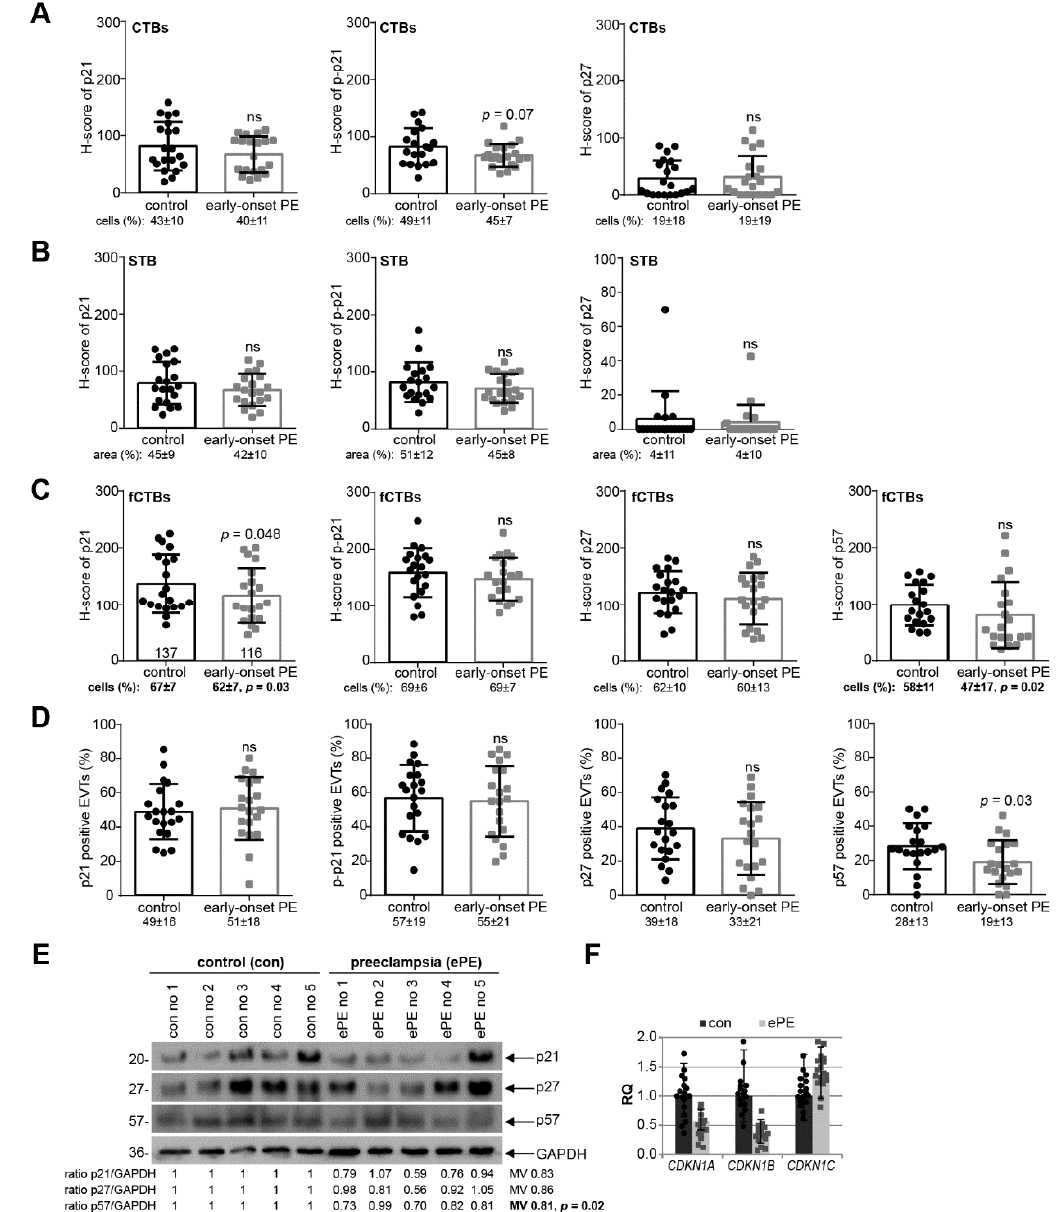
Figure 3. p21 expression is reduced in fCTBs of early-onset PE samples. ( A – C ) Quantification of cell cycle regulators in placental sections of control donors (control, n = 20) and patients with early-onset PE (ePE, n = 20) using the H-score method. The results are presented as bar and scatter plots showing the mean value with SD. The percentage of positive stained cells/area is shown under each graph. ( A ) H-score of p21 (left panel), p–p21 (middle panel), and p27 (right panel) for CTBs. ( B ) H-score of p21 (left panel), p–p21 (middle panel), and p27 (right panel) for the STB area. ( C ) H-score of p21 (left panel), p–p21 (second panel), p27 (third panel), and p57 (right panel) for fCTBs. ( D ) Quantification of p21 positive (left panel), p–p21 positive (second panel), p27 positive (third panel), and p57 positive EVTs (right panel) in %. ( E ) Western blot analysis with extracts from placental tissues is shown. Glyceraldehyde-3-phosphate dehydrogenase (GAPDH) served as the loading control. ( F ) The relative amount of the gene levels of CDKN1A (p21), CDKN1B (p27), and CDKN1C (p57) was analyzed from placental tissues. The results are presented as relative quantification (RQ) with minimum and maximum range. TBP was used as the endogenous control. Paired Student’s t -test or Wilcoxon-test was used for statistical analysis. CTBs, cytotrophoblasts; fCTBs, cytotrophoblasts ongoing to fuse; STB, syncytiotrophoblast; EVT, extravillous cytotrophoblasts; no, number; MV, mean value.